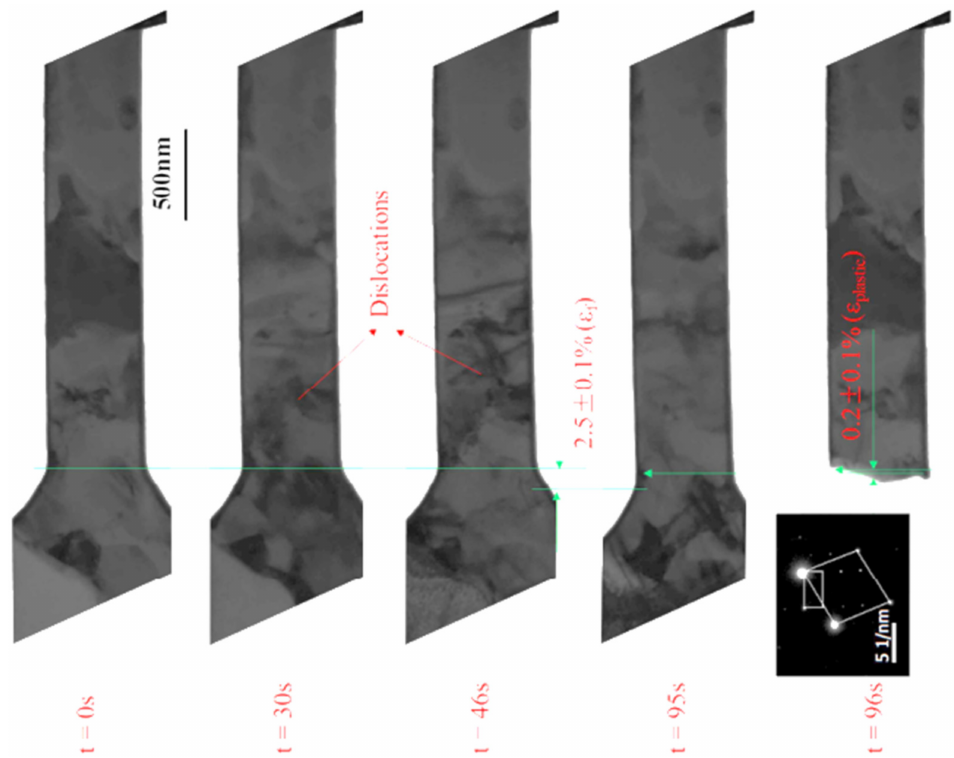
Figure 15. Fracture evolution for the tensile specimen containing HEA phase and (Ni, Co) Ti 2 compounds